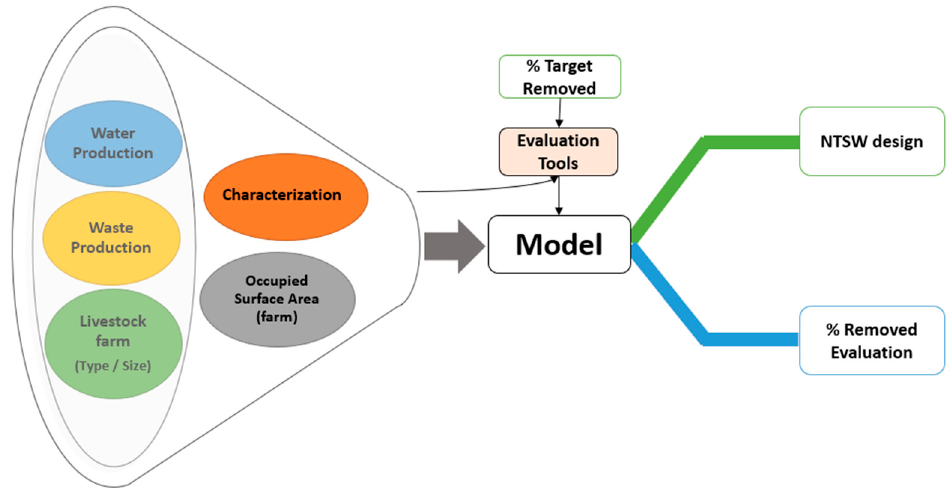
Figure 2. Model for the evaluation of livestock farms.